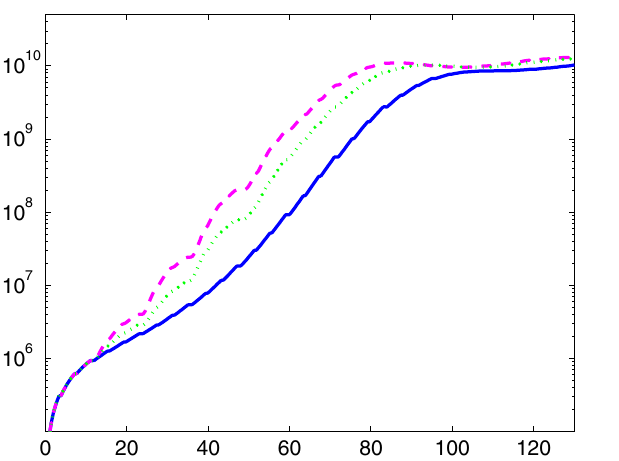
FIG. 4. (Color) SASE FEL power along the undulator without any optical klystron (blue solid curve), and with 4 optical klystrons for the rms energy spread of 1 (cid:9) 10 (cid:2) 5 (magenta dashed curve) and 5 (cid:9) 10 (cid:2) 5 (green dotted curve). The FEL wavelength is 1 : 0 (cid:1)A , and the undulator parameter K (cid:1) 2 : 7 . initial rms energy spread of 1 (cid:9) 10 (cid:2) 5 ) to study the FEL